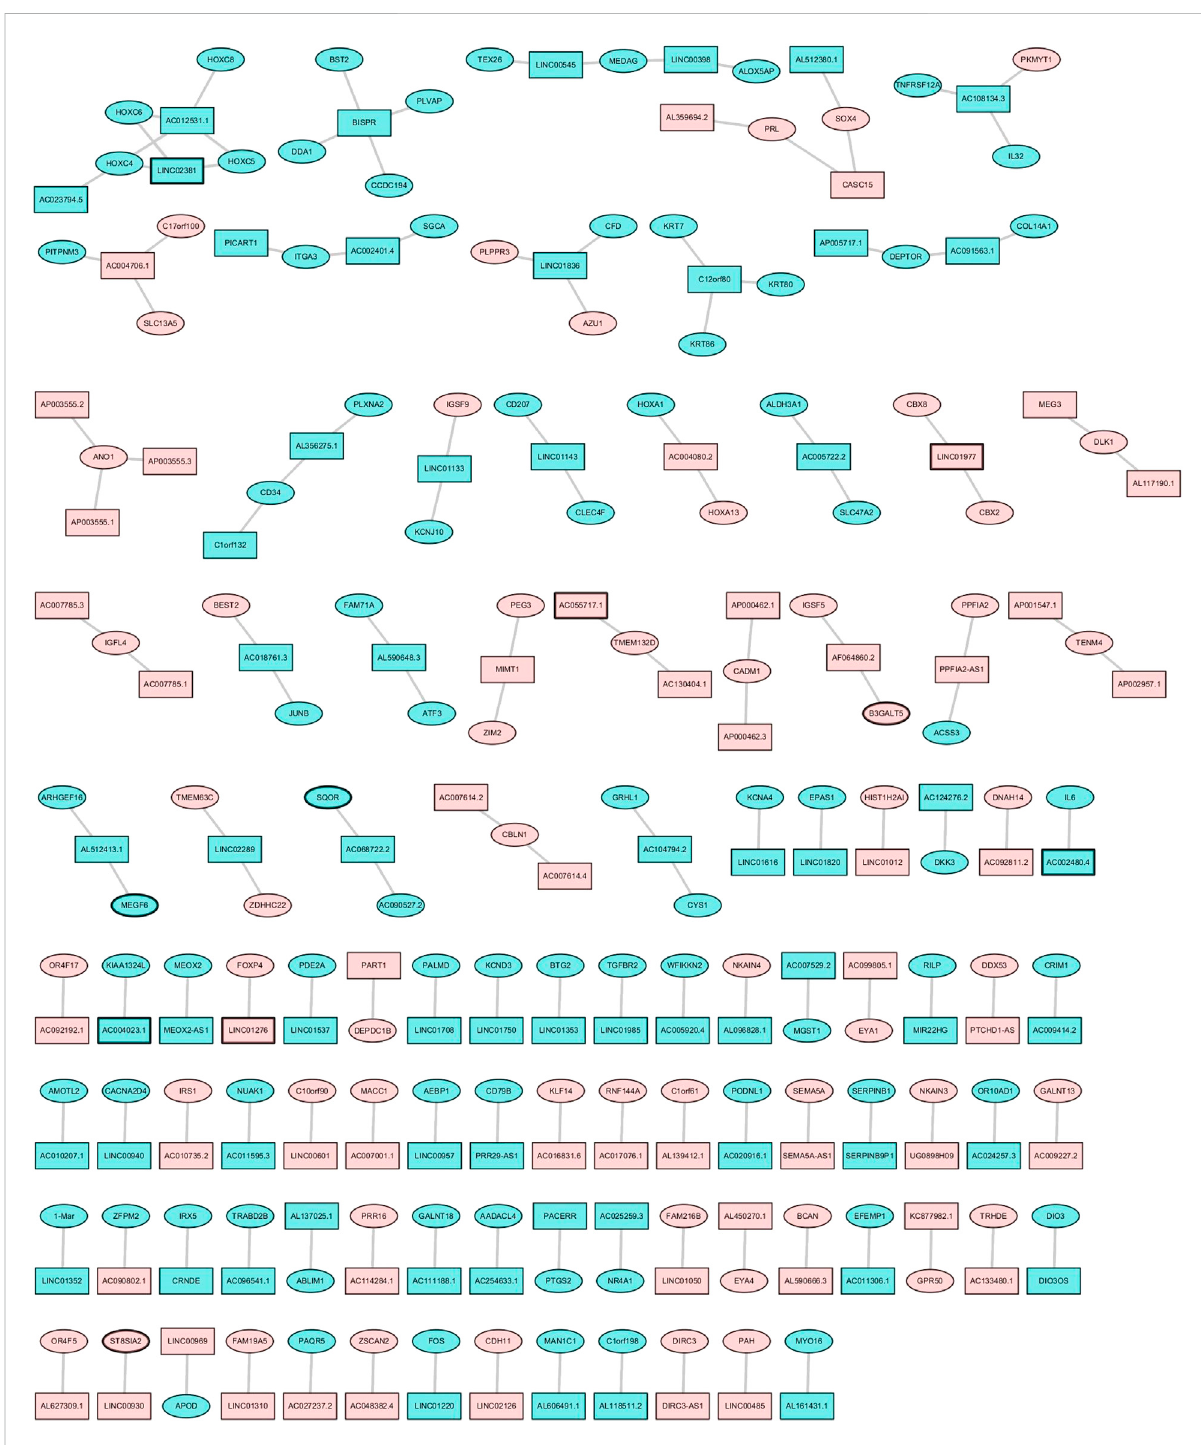
FIGURE 4 Cis-nearby-targeted DEmRNAs of DElncRNAs. There were 409 DElncRNA – nearby-targeted DEmRNA pairs, including 118 DElncRNAs and 136